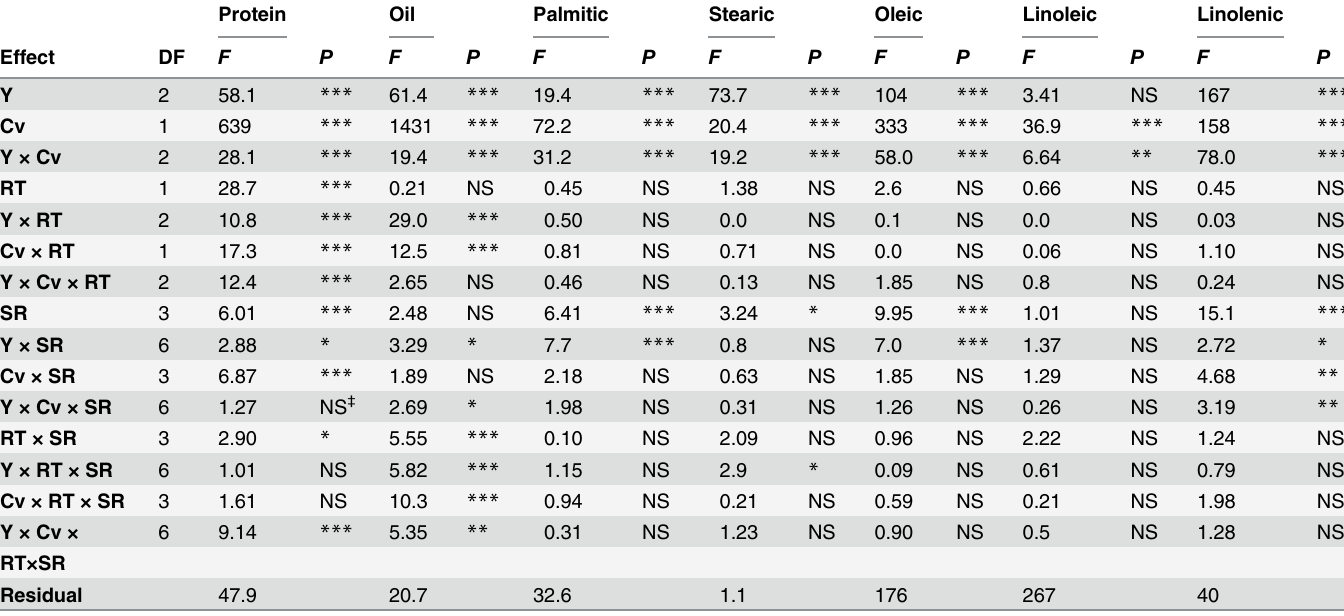
Table 2. Analysis of variance ( F and P values) of the effects of year (Y), cultivar (Cv), row-type (RT, either single- or twin-row), and seeding rate (SR) on the concentrations of seed protein, oil, and fatty acids (g kg -1 ) in soybean cultivars 94M80 and GP 533 in Beulah fine sandy loam soil. a Protein Oil